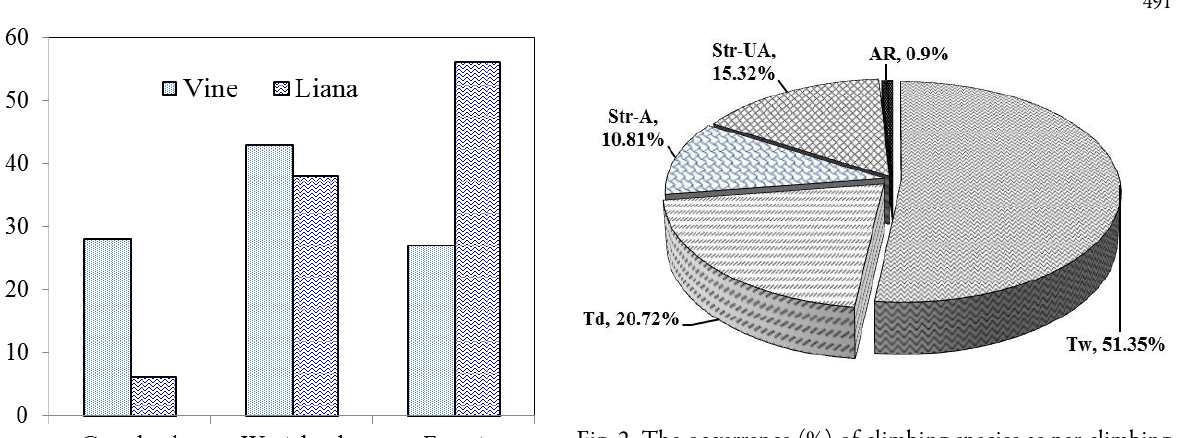
Fig. 2. The occurrence (%) of climbing species as per climbing modes within terrestrial landscape (Abbr. Tw: twining; Td: tendrilar; Str-A: straggling armed; Str-UA: straggling unarmed; AR: aerial root)